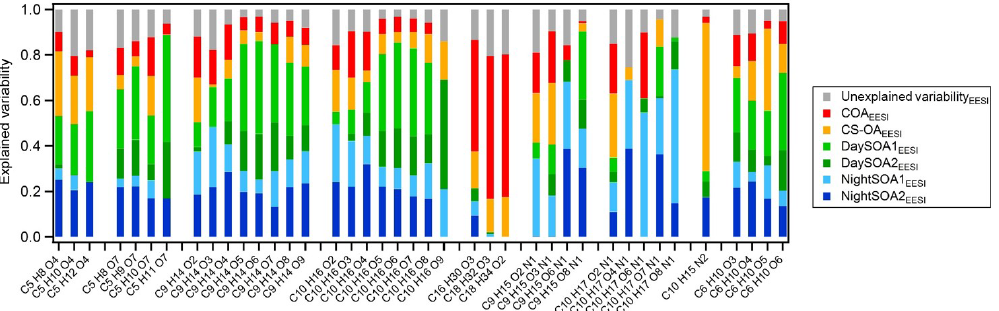
Figure 13. Explained and unexplained variability for a subset of compounds from the EESI-TOF-MS PMF analysis weighted on the explained variability of each factor. The subset of molecules has been selected according to the interesting species among all the variables in the analysis. Species are ordered according to their chemical composition. On average the C 5 species contribute 1.7% to the total signal measured, the C 9 H 14 O x ∼ 4%, C 10 H 16 O x ∼ 4 . 6%, C 16 − 18 ∼ 0 . 7%, C 10 H 17 O x N ∼ 1 . 7%, C 9 H 15 O x N ∼ 1 . 1%, C 10 H 15 N 2 ∼ 2 . 5%, C 6 H 10 O 5 ∼ 3 . 5%, and the remaining C 6 H 10 O x ∼ 0 .